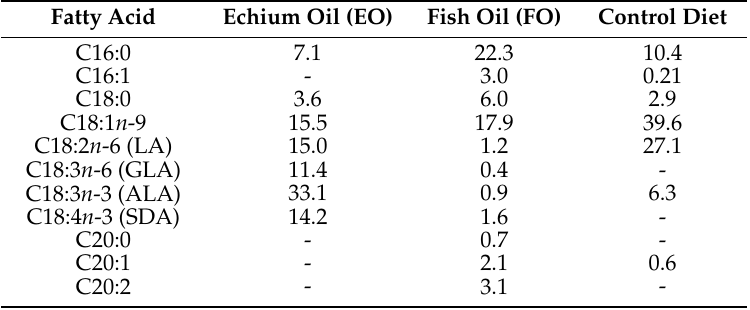
Table 1. Major n -3 and n -6 composition (% total fatty acids) of Echium oil, Fish oil and Control diet used in the